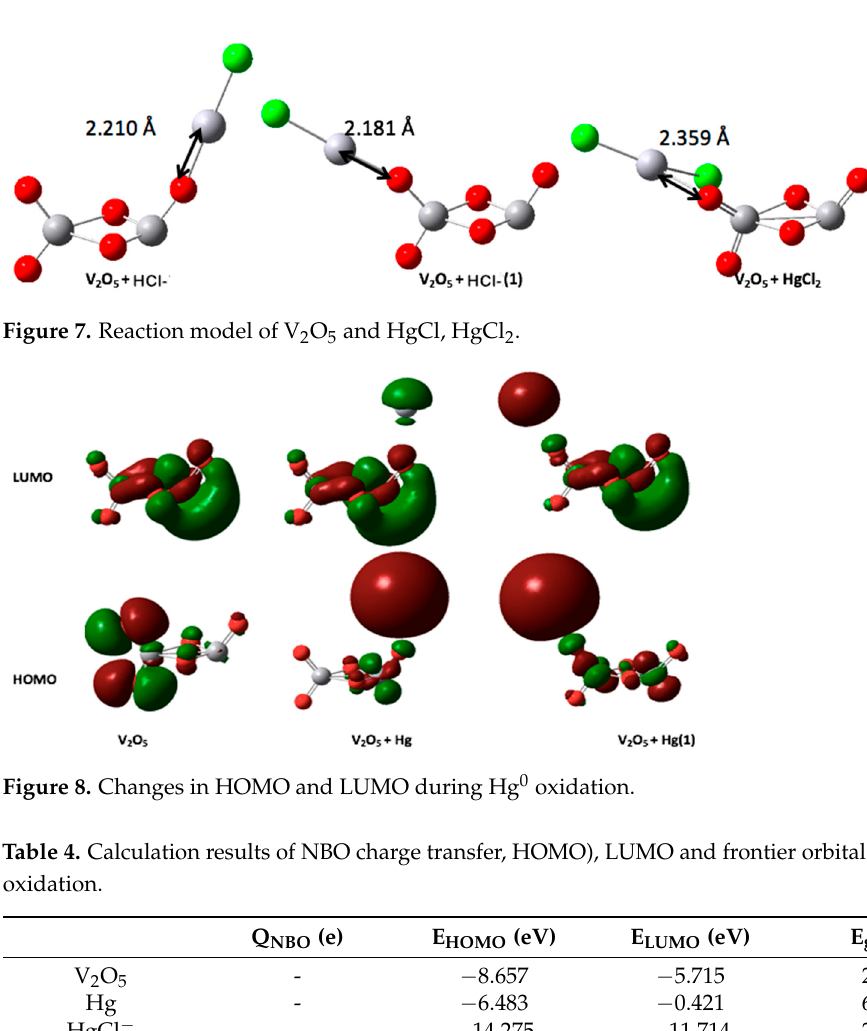
Figure 8. Changes in HOMO and LUMO during Hg 0 oxidation. Table 4. Calculation results of NBO charge transfer, HOMO), LUMO and frontier orbital during Hg 0 oxidation.